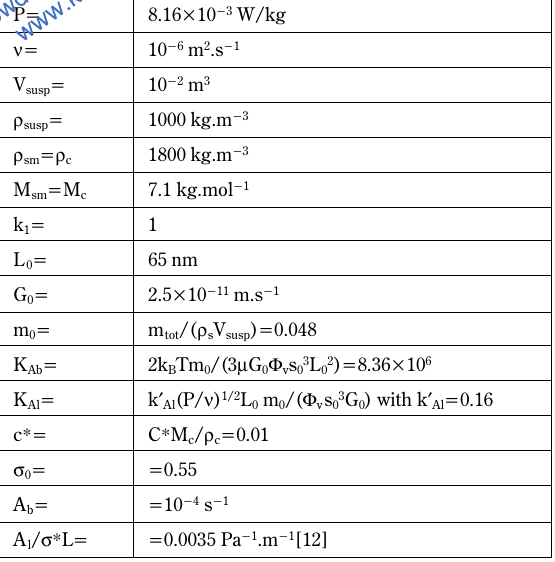
Table 5 Values of parameters of the simulation presented in Fig. 5